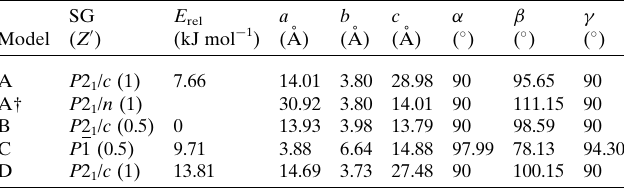
Table 7 Results of the force-field optimizations of the four structural models, including optimization of the lattice